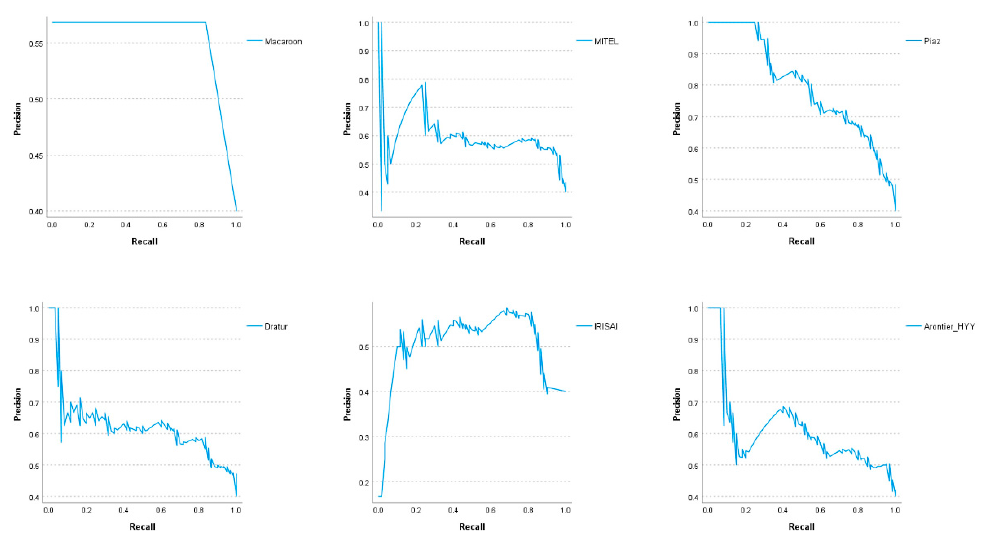
Figure 9. Precision–recall curves for the methods proposed by the six best teams in the test dataset.